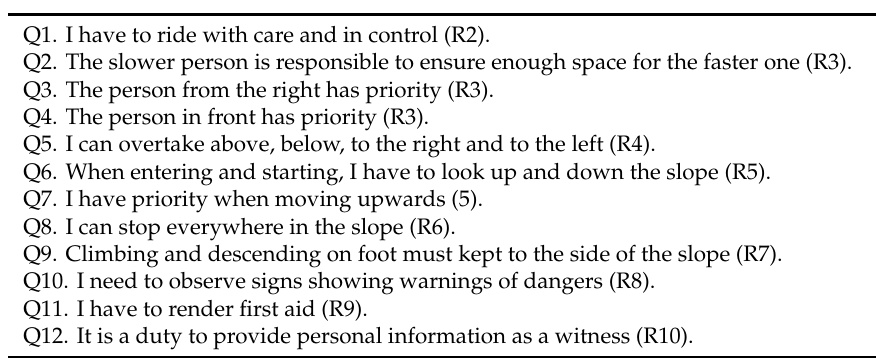
Table 1. Passive knowledge: intuitive behavior for given situations on ski slopes (R: corresponding